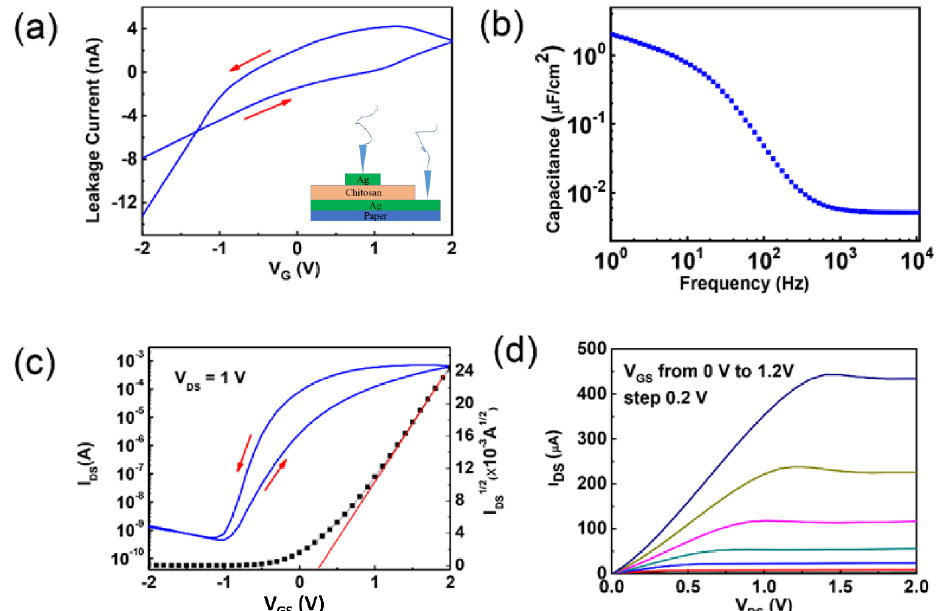
Figure 2. ( a ) Leakage current curve of the chitosan electrolyte membrane, the insert is the Ag/chitosan/Ag sandwiched testing structure; ( b ) Frequency-dependent specific capacitance curve of the chitosan gate dielectric film; ( c ) Transfer characteristic curve of the flexible IWO-based TFT; ( d ) Output characteristic curve of the flexible IWO-based TFT. Table 1. Recent advances in oxide-based TFTs gated by a chitosan gate dielectric. Channel Layer SS [V/Decade]